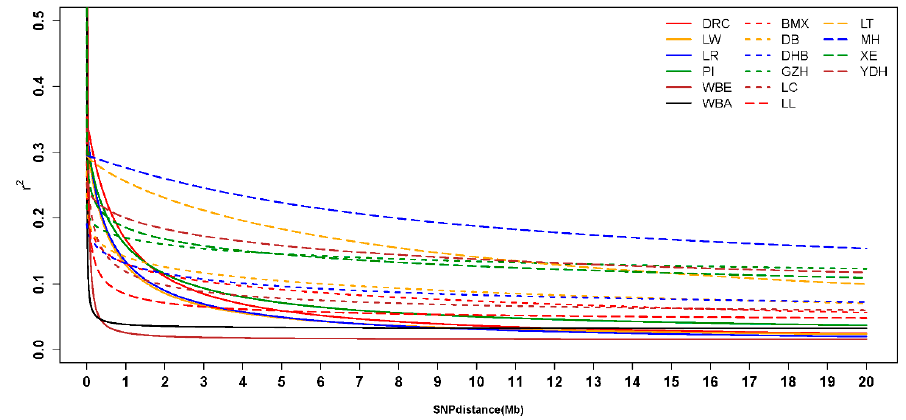
Figure 5. Extent of linkage disequilibrium (LD) for each breed 1 . 1 DR = Duroc, LW = Large White, LR = Landrace, PI = Pietrain, WBE = European wild boars, WBA = Asian wild boar, BMX = Bamaxiang, DB = Debao, DHB = Dahuabai, GZH = Guizhonghua, LC = Luchuan, LL = Longlin, LT = Lantang, MH = Meihua, XE = Guangdongxiaohua, YDH = Yuedonghei.